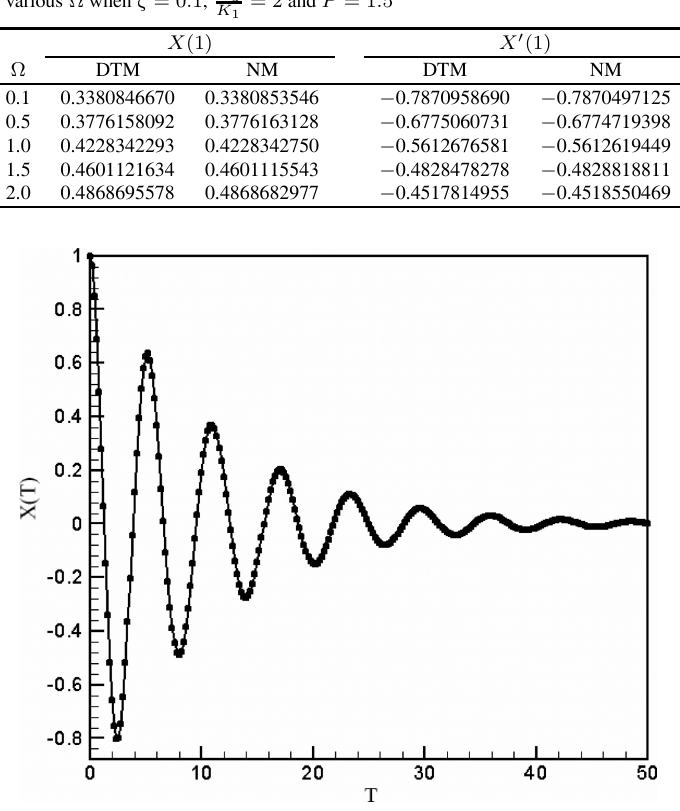
Fig. 4. The comparison between the numerical solution and DTM solution of X ( T ) when ζ = 0 . 1 , K 3 K line denote DTM solution and symbols show the numeric